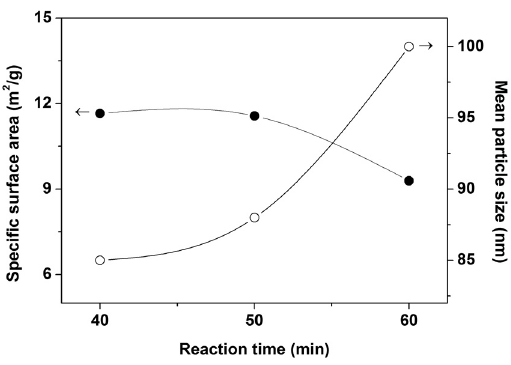
Figure 2: BET surface area and mean particle size vs. reaction